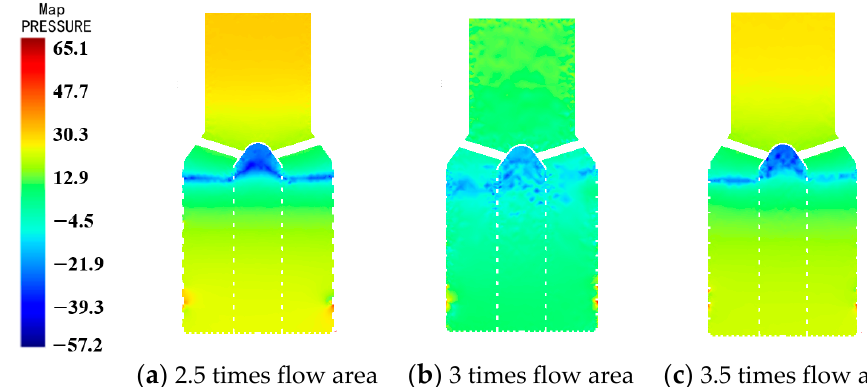
Figure 29. Sound pressure level distribution of different schemes at the first peak.